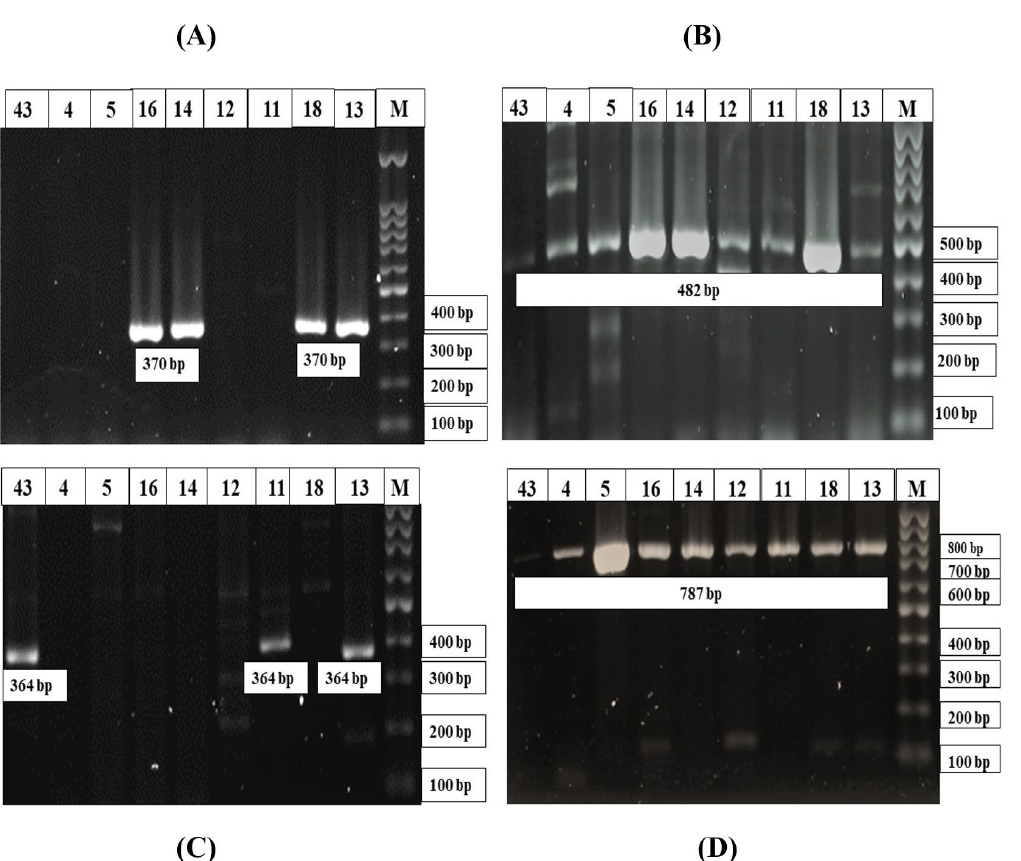
Fig. 3. Representative Image of gel electrophoresis of Polymerase Chain Reaction (PCR) for detecting aminoglycoside modifying enzyme (AME)